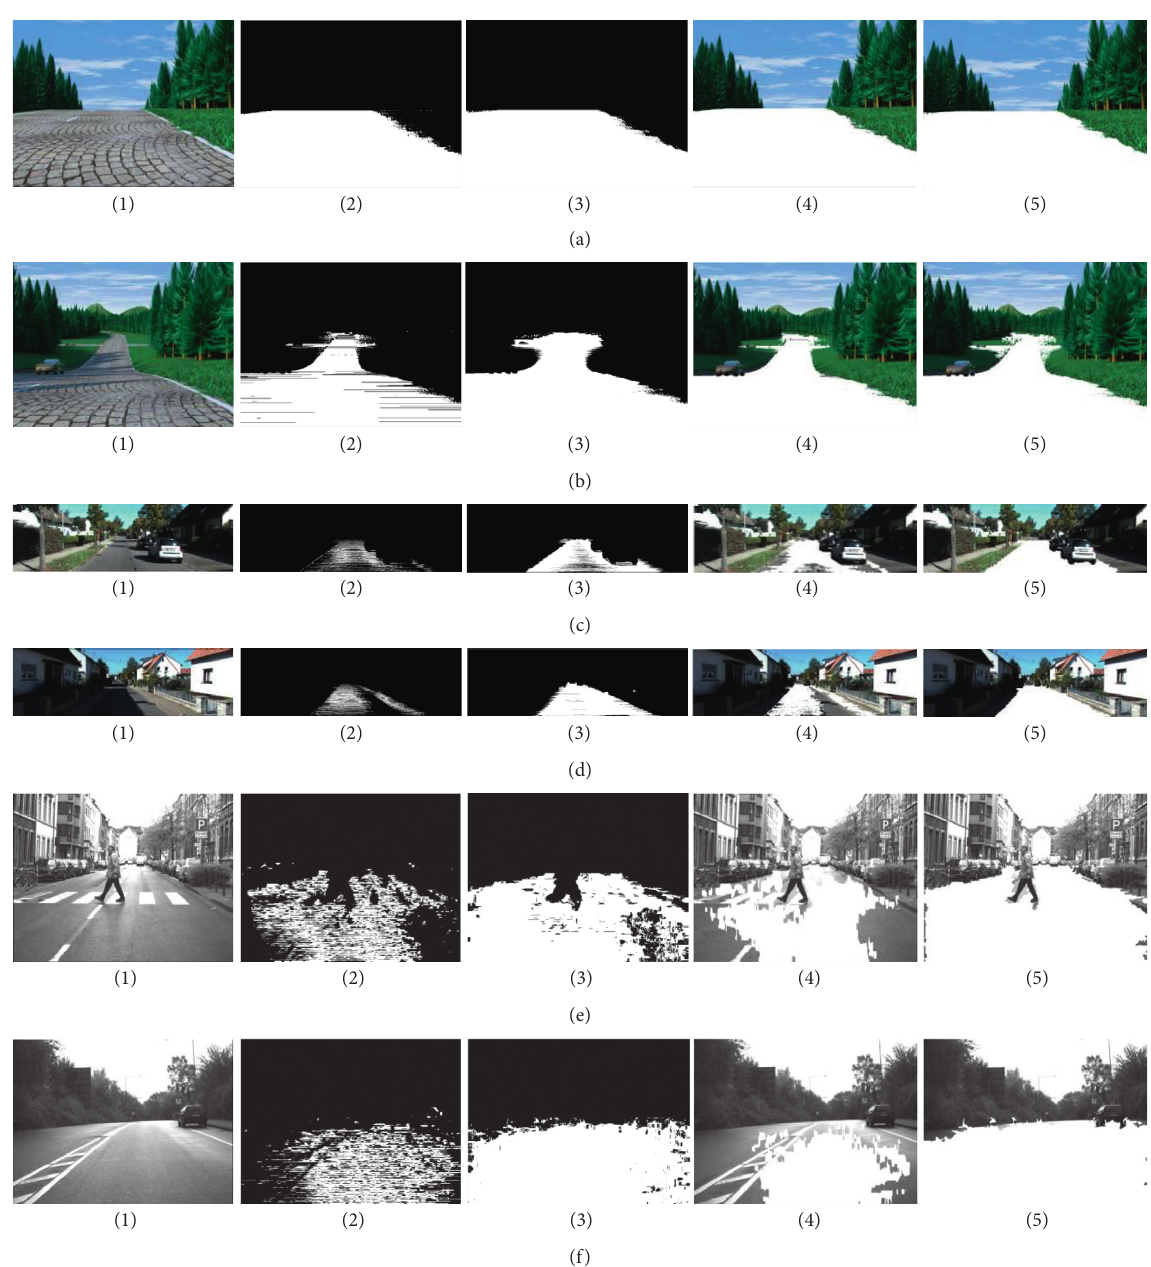
Figure 9: Typical road pavement detection results. (1) Original image (left). (2) Initial road contour for NT-RD method. (3) Initial road contour for ours. (4) Road detection result for NT-RD method. (5) Road detection result for